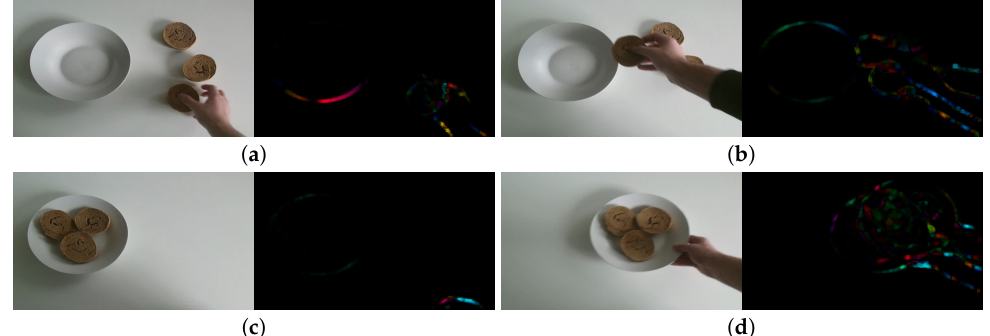
Figure 9. Visualization of Dense Optical Flow with Farneback: ( a ) moving ntakos, ( b ) mov- ing ntakos inside the plate, ( c ) no move, ( d ) moving plate with ntakos.